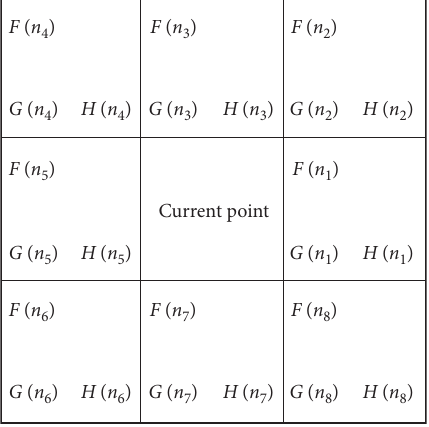
Figure 3: Searching process by A-star